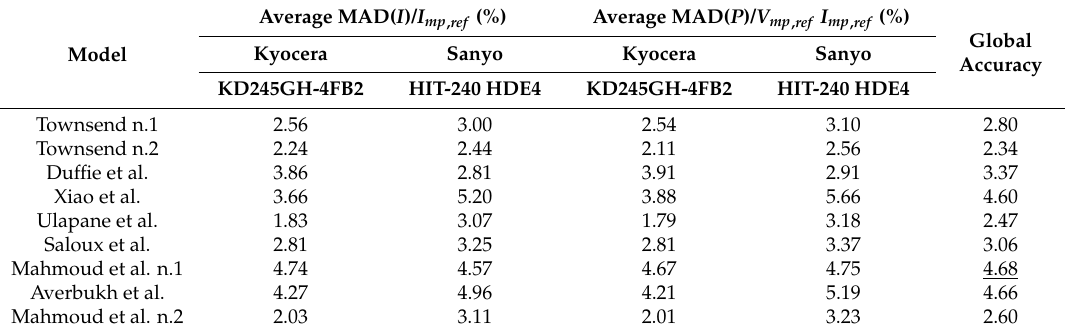
Table 15. Average ratios of MAD( I ) to the rated current at the MPP andof MAD( P ) to the rated maximum